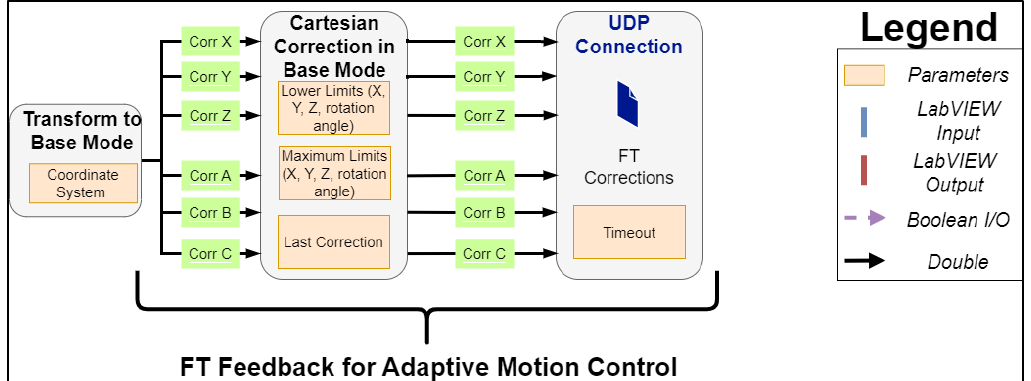
Figure 4. Expansion of the control process algorithm of kinesthetic path planning (Figure 3) to support the direct feedback of the FT corrections to the LabVIEW environment for adaptive motion control .